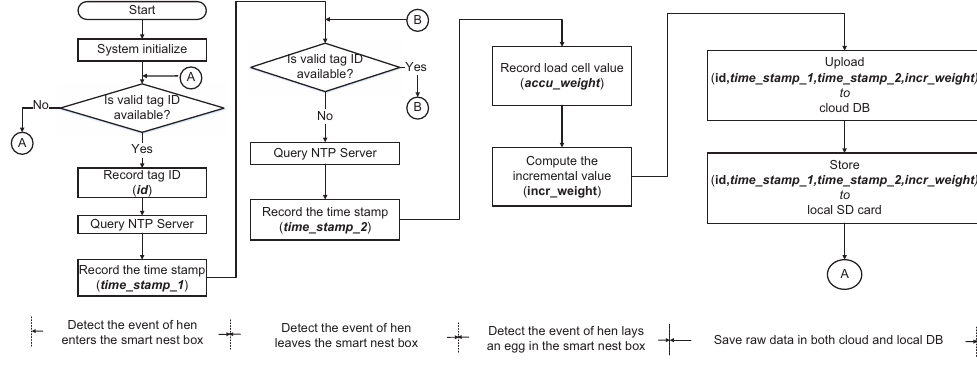
Figure 4. Flowchart of the IoT platform.